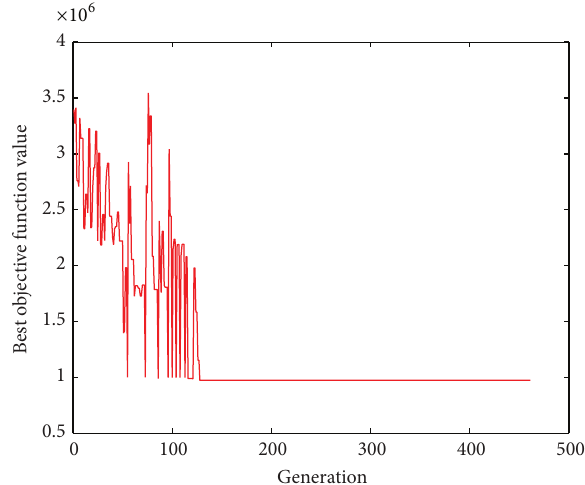
Figure 9: Trends of optimal objective function value by PPGASA.